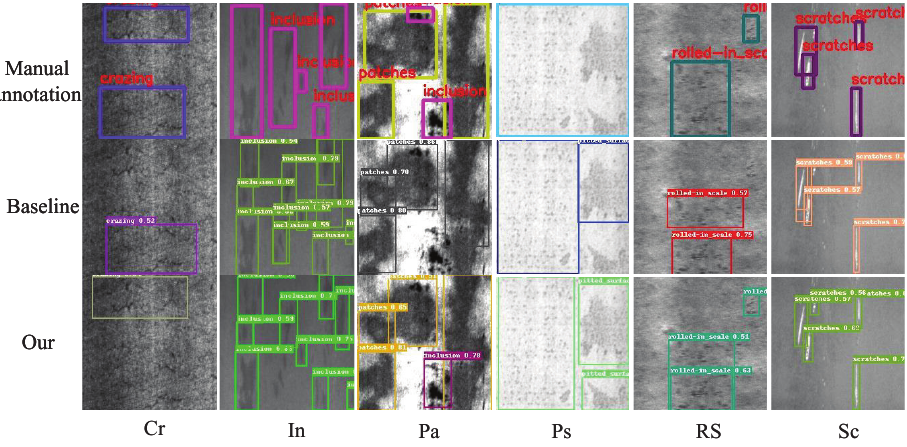
Figure 11. The detection results of the PP-YOLOE-m and improved PP-YOLOE-m networks on the NEU-DET